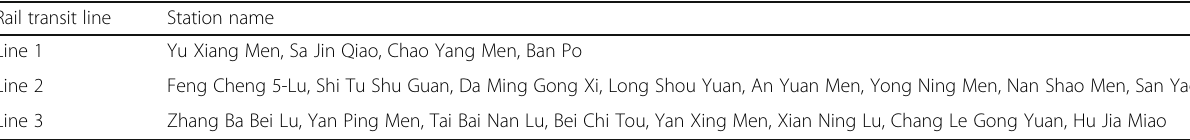
Table 2 High population density rail transit stations in Xi ’ an Rail transit line